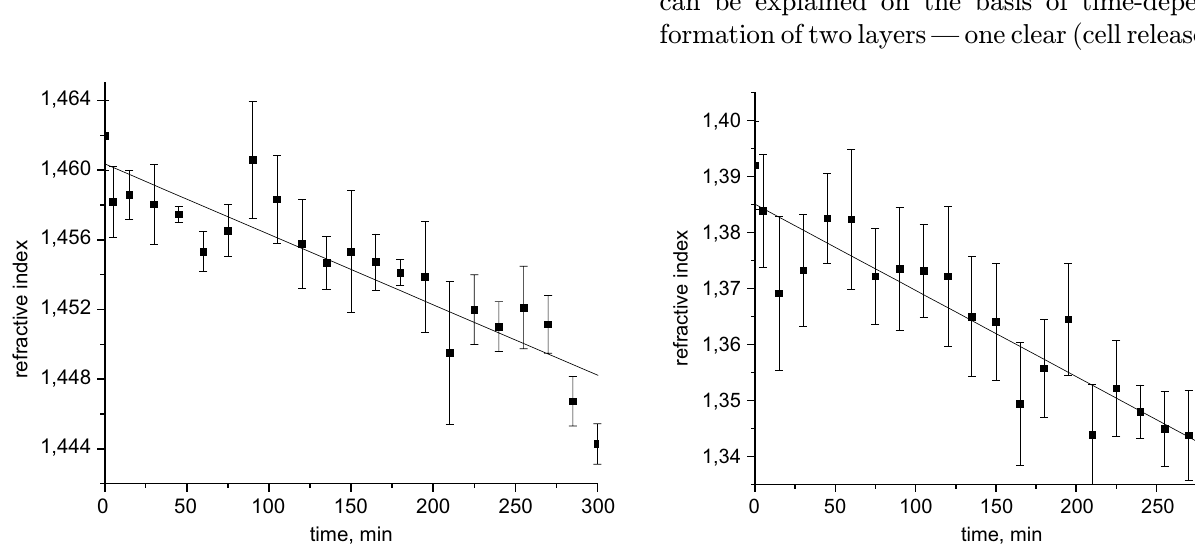
Fig. 5. The e®ective refractive index vs time elapsed after PDT for BG-stained fat tissue slice (diode lamp-irradiation during 15 min). These are the statistical results for three inde- pendent measurements; solid line shows the linear ¯t by n ¼ 1 : 460 (cid:1) 4 (cid:3) 10 (cid:1) 5 t (min).